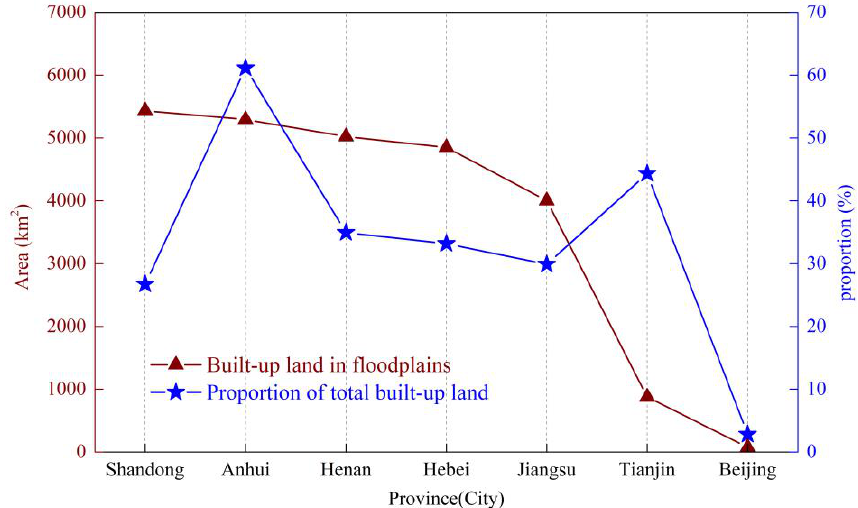
Figure 5. Area of built-up land in floodplains and its proportion of the total built-up land area of each province and city in 2014.